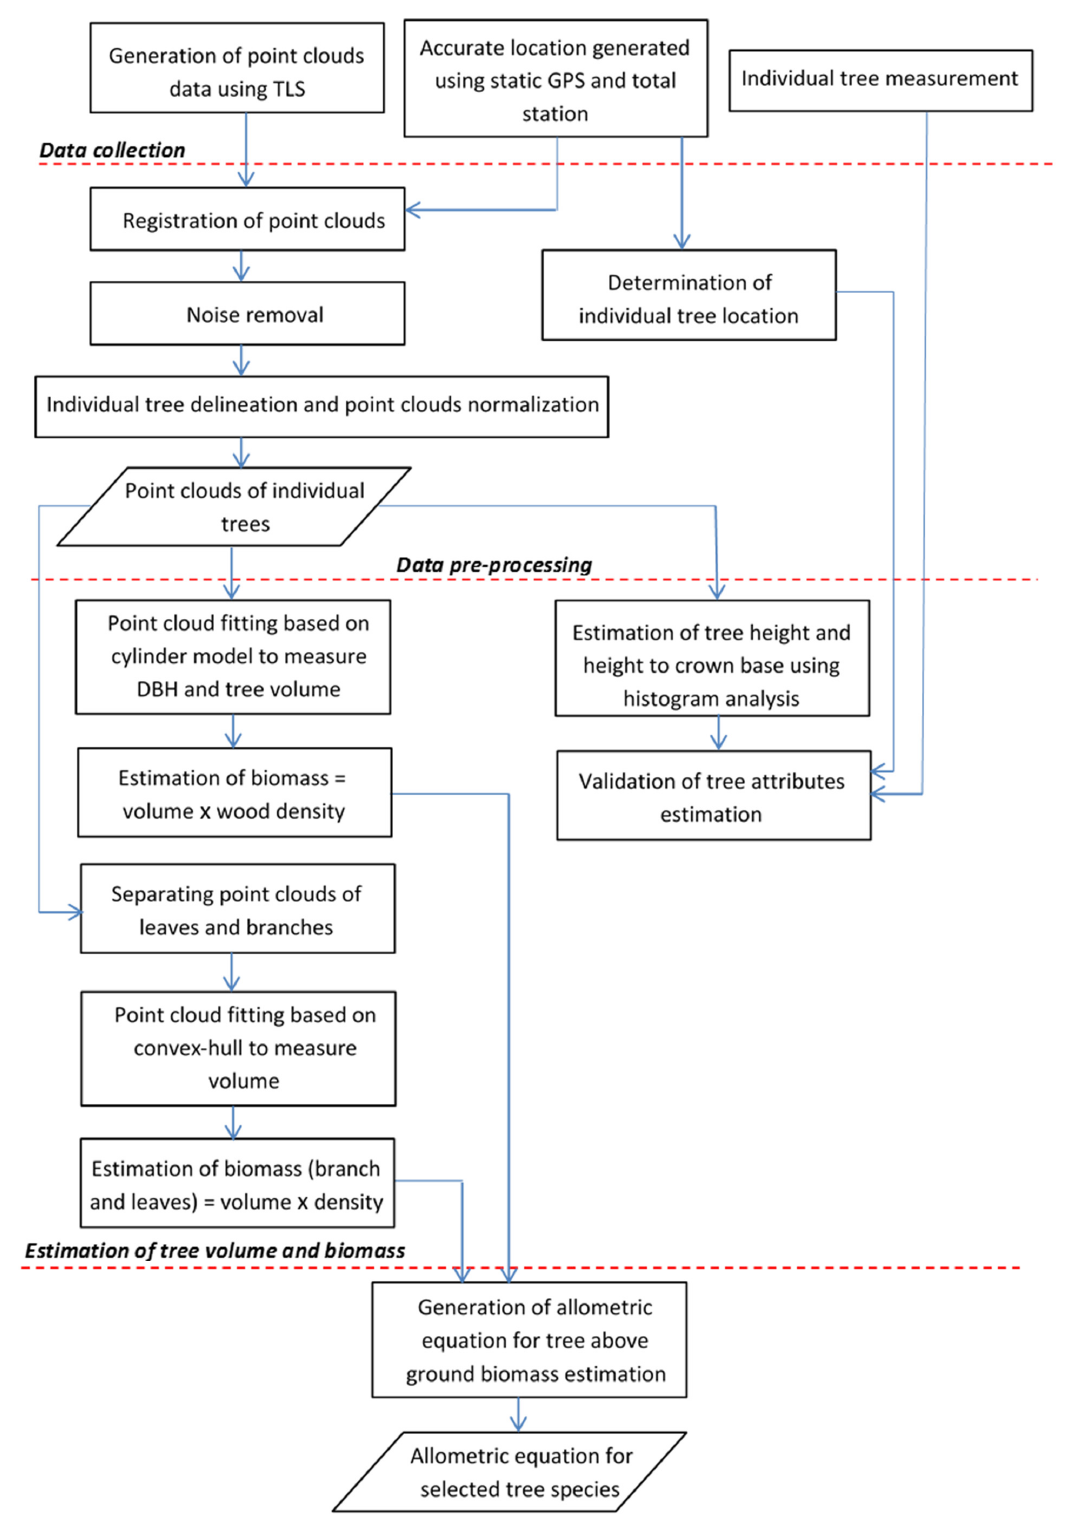
Figure 2. Flow chart of general methodology.